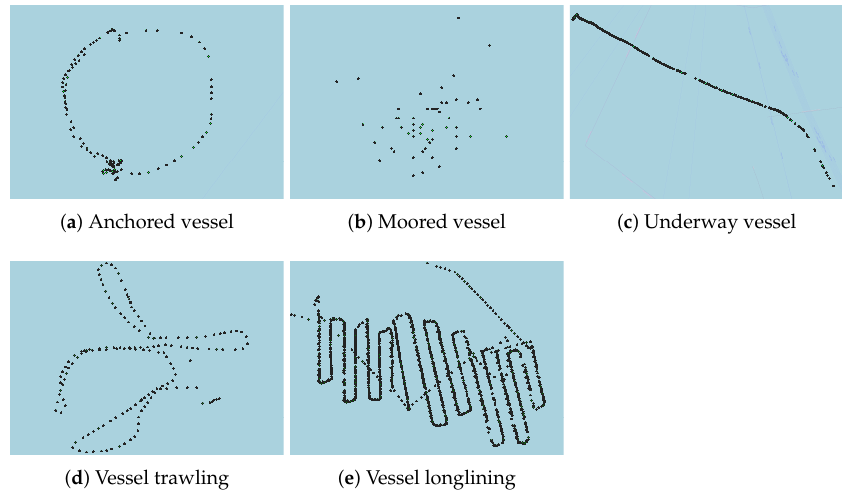
Figure 1. The different vessels’ mobility